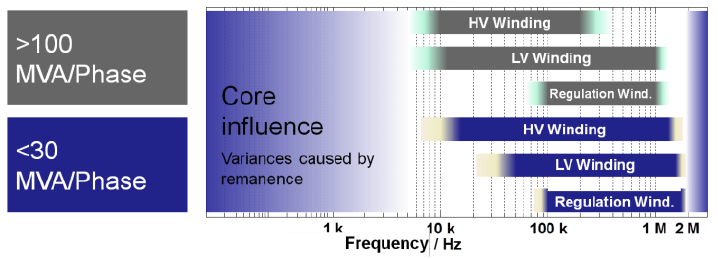
Figure 11. Frequency ranges with known sensitivity towards changes of the winding geometry [20].